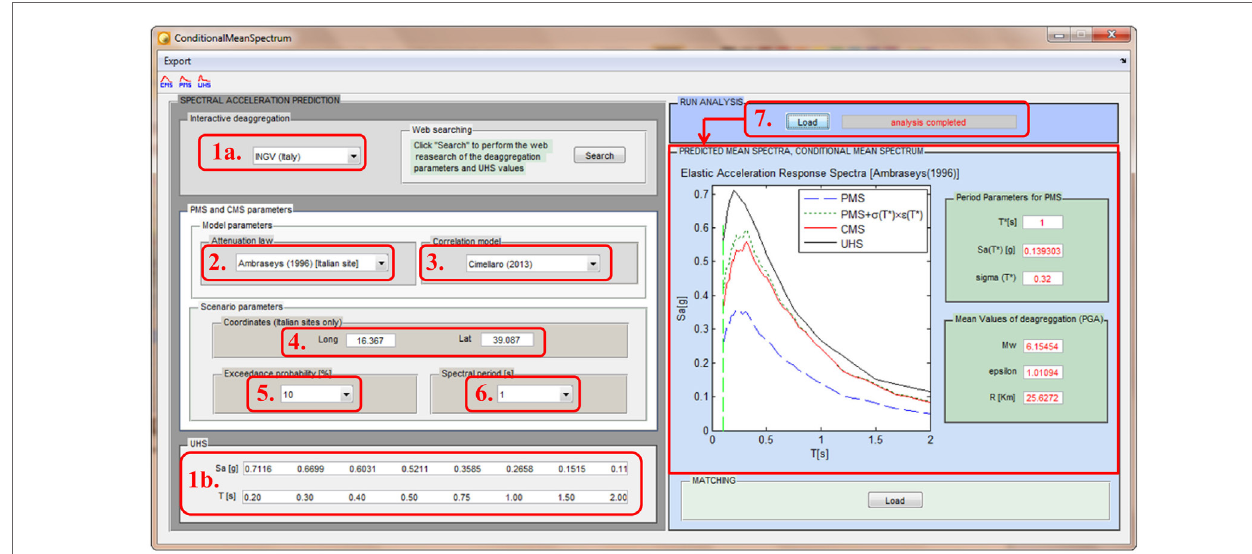
FigUre 3 | User dialog window for defining the cMs .